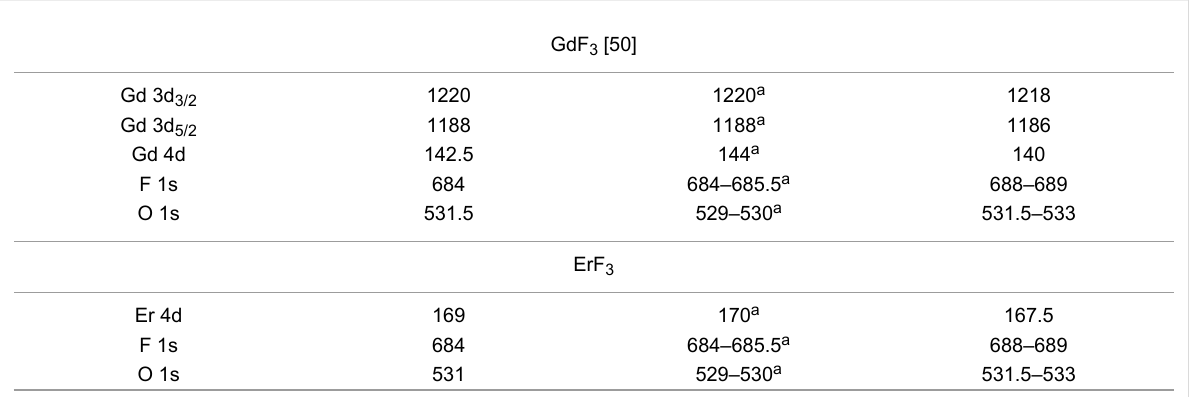
Table 2: Comparison of XPS binding energies in REF 3 -NP samples in [BMIm][BF 4 ]. (continued)